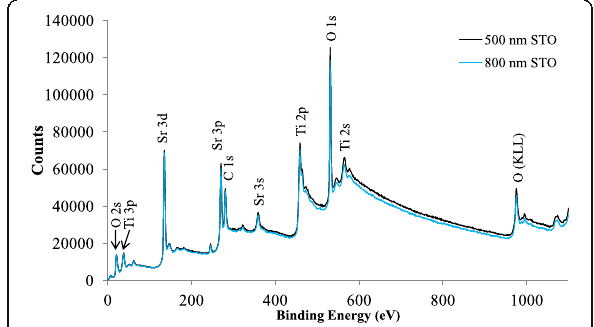
Fig. 6 XPS spectra of STO films grown at a chamber pressure, laser frequency, and substrate temperature of 10 − 4 mbar, 10 Hz, and 500 °C, respectively, with a thickness of 500 and 800